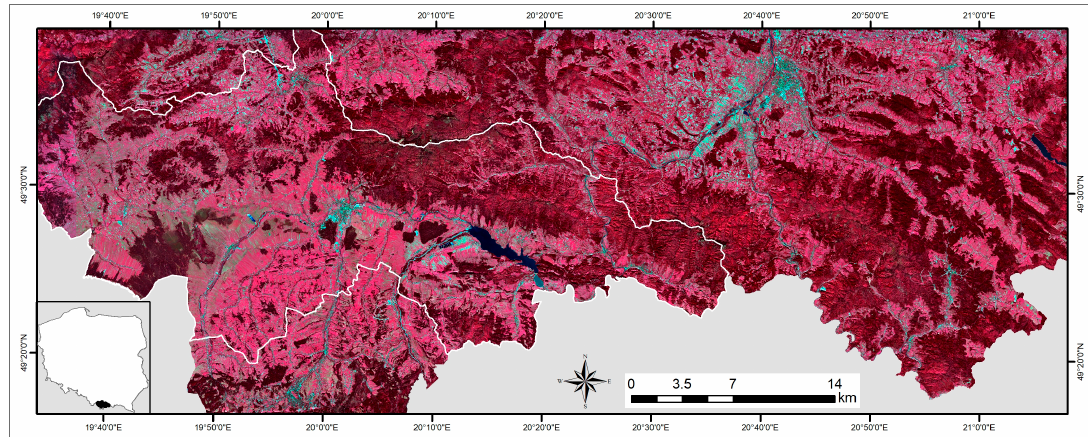
Figure 1. Location of the study site. The color composite of Sentinel-2 from 2 October 2017 (bands 8, 4 and 3) with outline of the border of the Nowy Targ district.